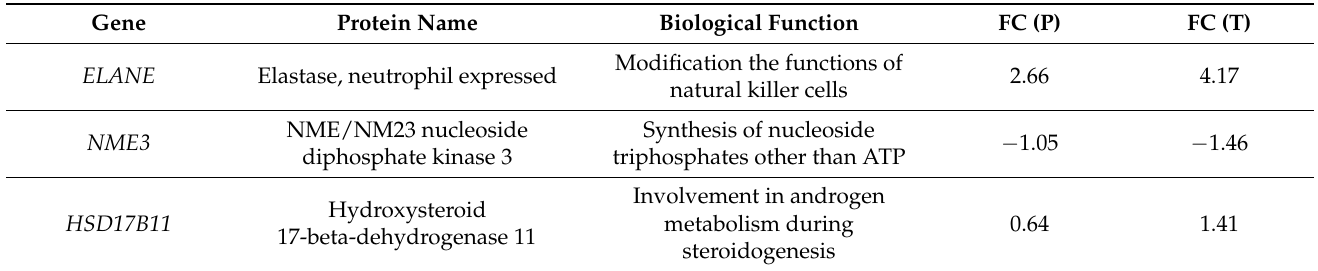
Table A1. Combined analysis of transcriptome and MS-based proteome datasets of PRE-R and PRE-NR sample groups.